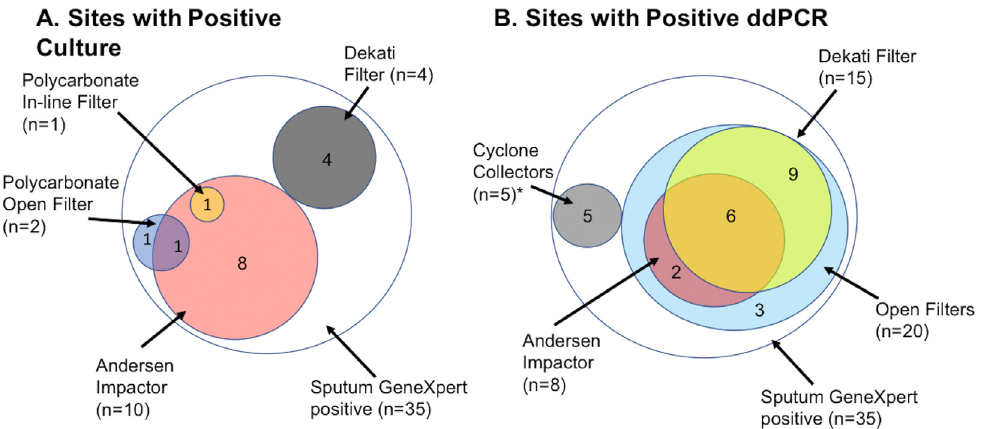
Figure 1. Euler Diagrams demonstrating successful detection sampling modalities for A . mycobacterial culture and B . ddPCR (25 positive out of 27 successfully tested). *Cyclone Collectors were added for the later participants. These included a NIOSH two-stage cyclone aerosol sampler (2 positive out of 4 participants sampled) and Coriolis µ biological air sampler (3 positive out of 3 participants sampled).